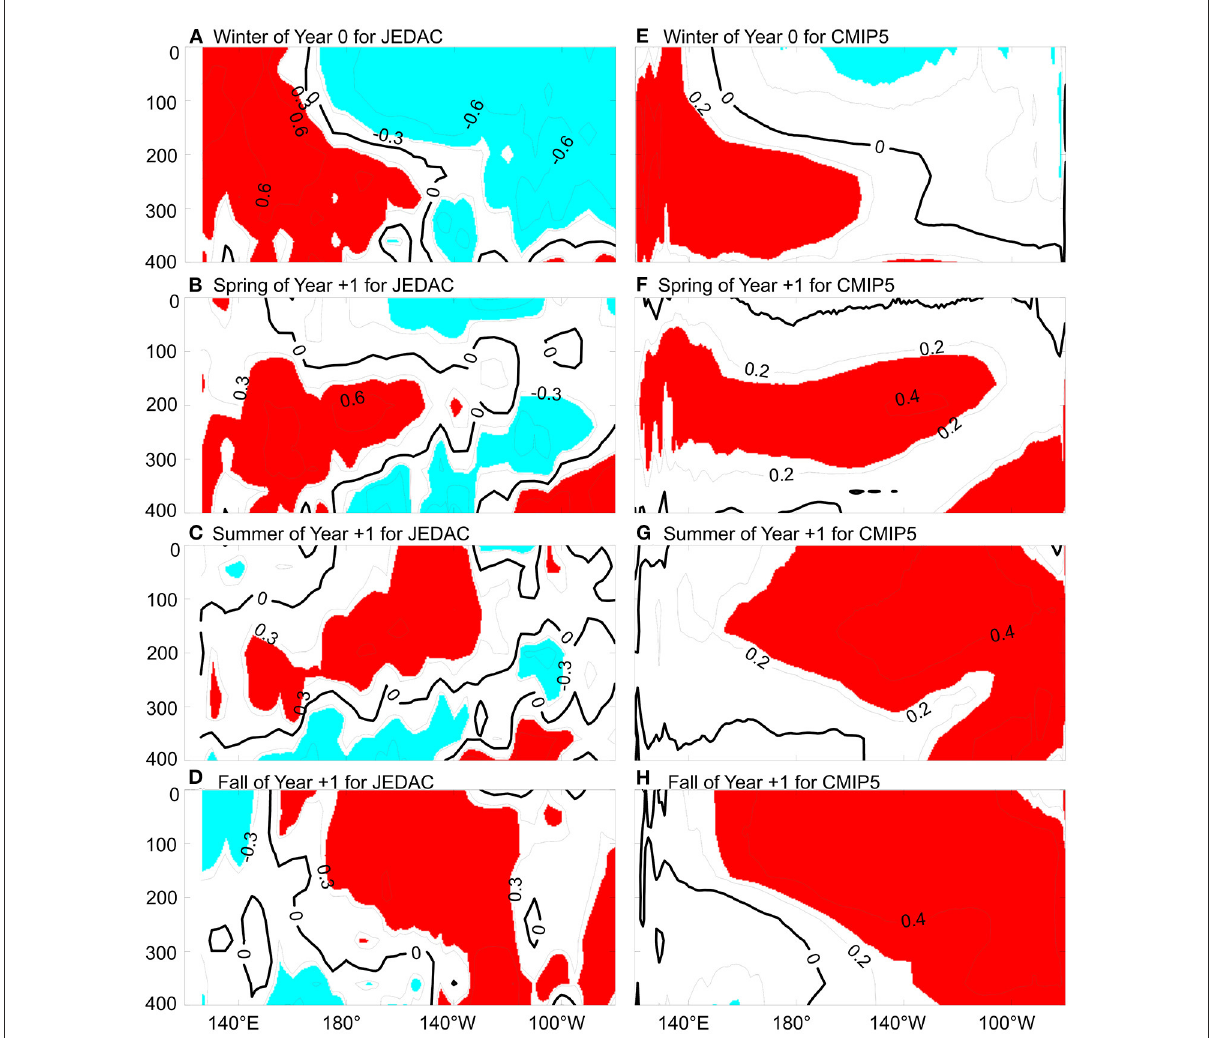
FIGURE7 Lag correlations between the STIO SSTA in the fall of Year 0 and the subsurface temperature anomalies in the vertical section along the equatorial Pacific from the winter of Year 0 through the fall of Year + 1 during positive phases. (A–D) JEDAC. (E–H) cross-model averaged from CMIP5 historical simulations. The red and blue shading indicate the 95% significance level of positive and negative correlations,